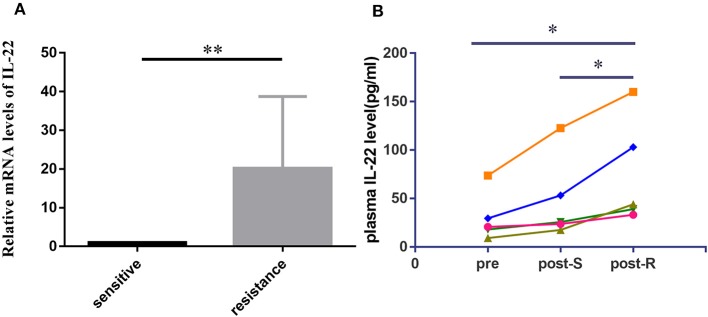
IL-22 expression levels in human lung cancer tissue and plasma. (A) IL-22 mRNA expression levels assessed in 20 cases of EGFR-mutant patients before treatment (10 cases) and upon acquired resistance to EGFR-TKIs (10 cases). Data were means of two separate experiments mean ± SEM. (B) Pre to post changes in 5 pair of plasma measured with the ELISA assay. Individual patients are depicted with a straight line connecting pre, post-S and post-R. *P < 0.05, **P < 0.01. pre, pre-treatment; post-S, post-treatment (sensitive to EGFR-TKIs); post-R, post-treatment (acquired resistance to EGFR-TKIs).